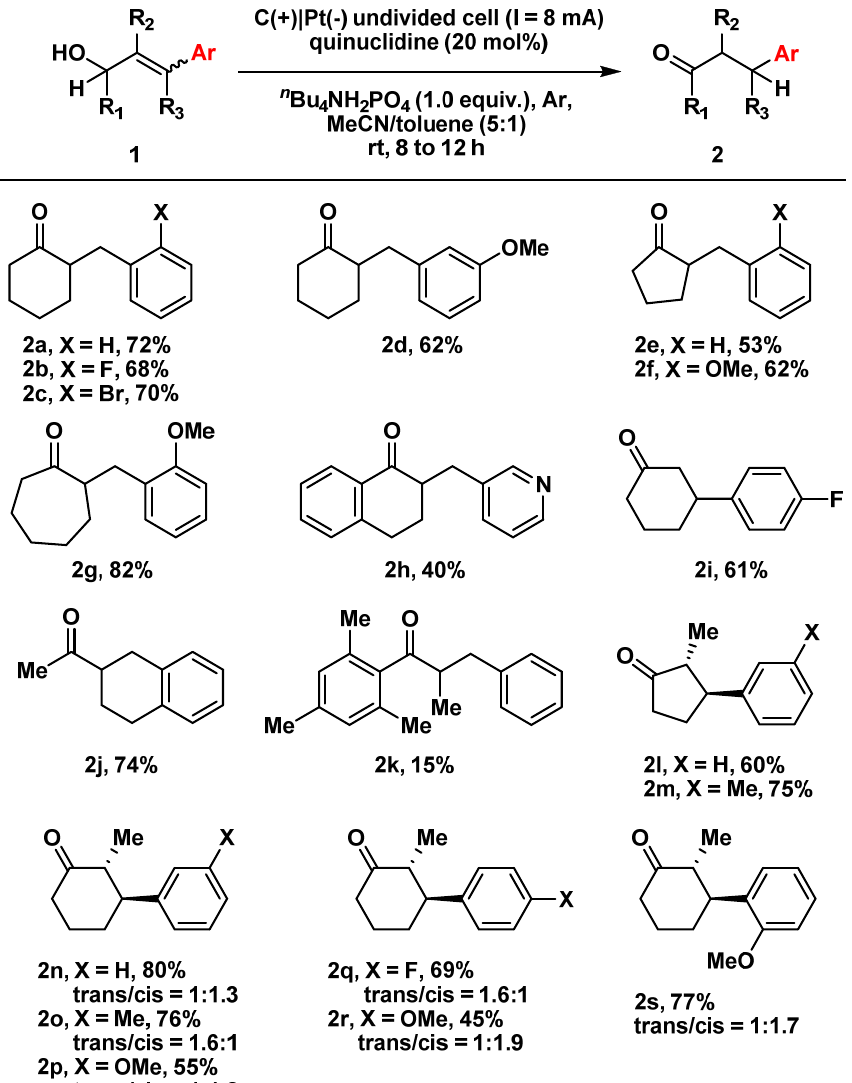
Figure 2. Substrate scope of γ -aryl-allylic alcohols. Reactions were conducted at a 0.5 mmol scale using standard reaction conditions. All tri-substituted allylic alcohol substrates were E-isomers. The trans/cis ratios of products were determined by 1 H-NMR spectra.